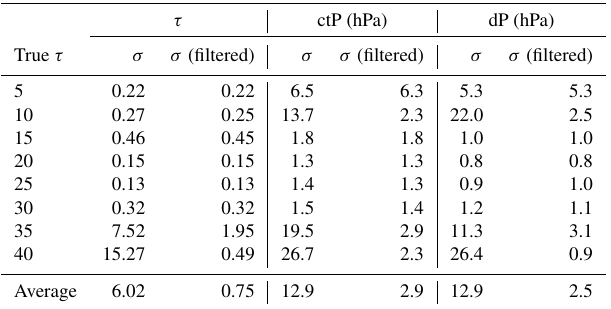
Table 1. Posterior errors estimated from the sample standard devia- tions of the retrieval output. In each case, σ refers to the full sample standard deviation and σ (filtered) refers to the sample standard de- viation excluding those with the 10% highest values of χ 2 . The bottom row shows the mean of the standard deviations entered in each